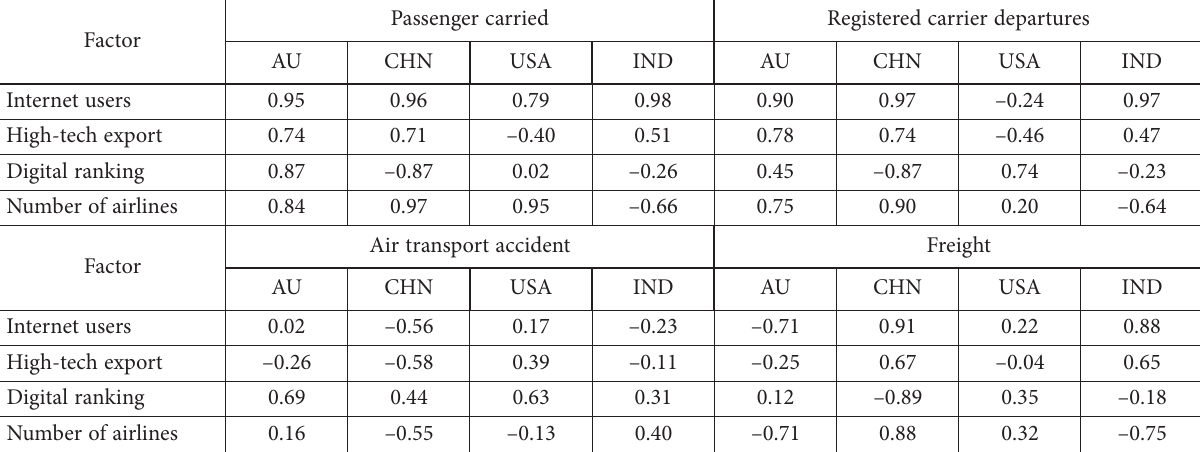
Table 3. Correlation analysis result for four sample countries from 2008 to 2017 Passenger Factor